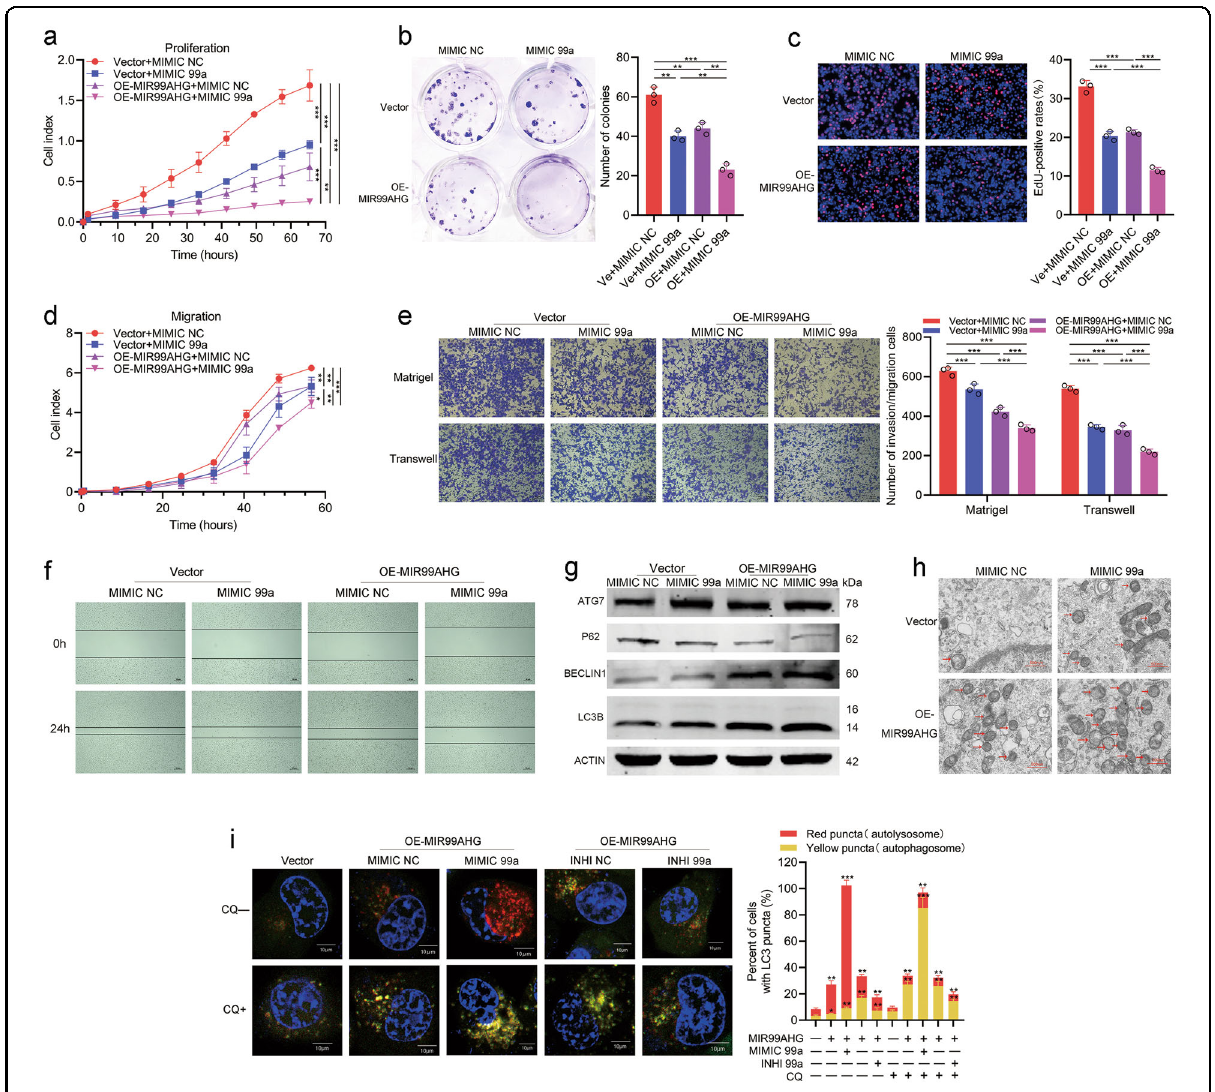
Fig. 7 miR-99a cooperates with MIR99AHG to exert biological effects. a – c Proliferation ability of transfected H1299 cells as indicated is shown by RTCA proliferation assays ( a ), colony formation assays ( b ) and EdU assays ( c ). d – f Migration and invasion ability of indicated H1299 cells is shown by RTCA migration assays ( d ), transwell and Matrigel assays ( e ), and wound-healing assays ( f ). g – i Autophagy level of the indicated H1299 cells is shown by WB assays ( g ), TEM ( h ), and autophagic fl ux experiments ( i ). All experiments were repeated three times with similar results and images are representative of three independent experiments. A two-tailed Student ’ s t -test was used for statistical analysis. * P < 0.05, ** P < 0.01, *** P < 0.001. Error bars,